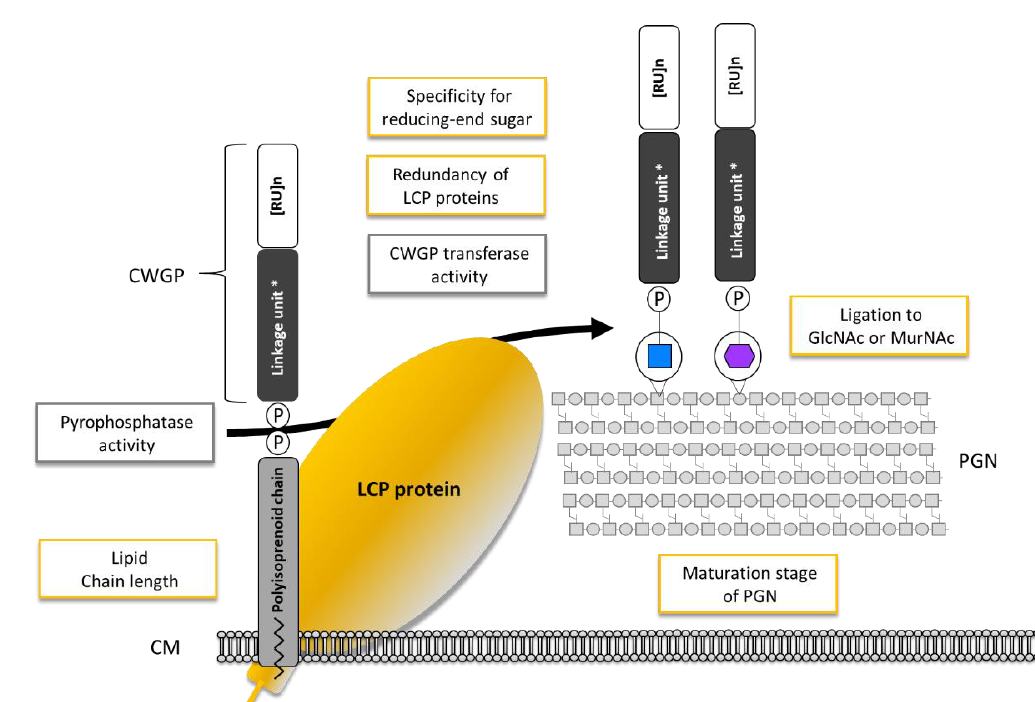
Figure 2. Most common scenarios of ligation of CWGPs to PGN by LCP enzyme activity. The reaction is shown with a schematic CWGP structure comprised of the glycopolymer chain and a possible PGN linkage unit (*). LCP protein functions are boxed in black, open key points of the catalytic reaction are boxed in yellow. CM, cytoplasmic membrane; P, phosphate.